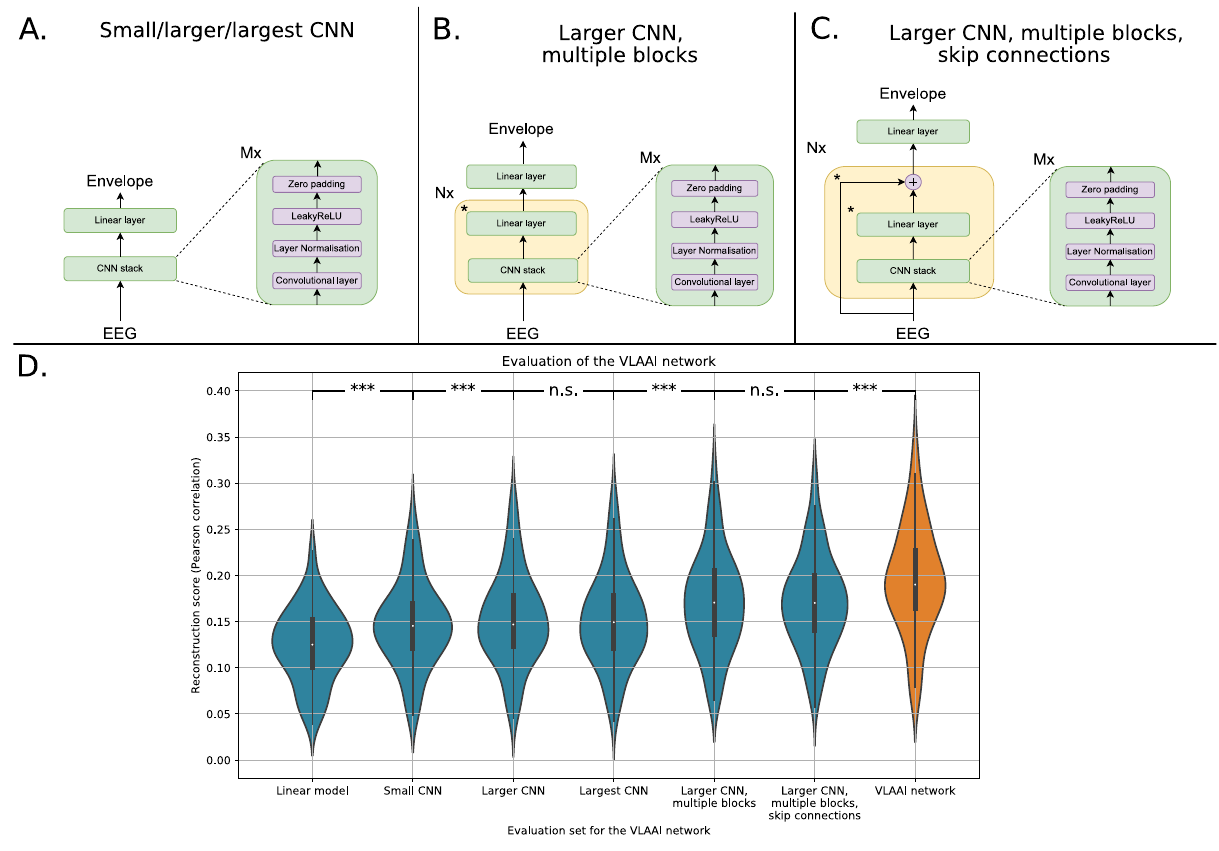
Figure 3. ( A ) The small/larger/largest CNN model. For the small CNN ( M = 2), the convolutional layers have a kernel size of 20 and 256 filters. The large CNN has five convolutional layers ( M = 5) with 256 filters for the first three layers and 128 filters for the last two filters, all with a kernel size of 8. The largest CNN also has five convolutional layers ( M = 5), all with 512 filters and a kernel size of 8. ( B ) The larger CNN, multiple blocks, following the structure of the larger CNN model. The asterisk next to the linear layer highlights that it is not present in the last repetition of that block. For the experiment shown in ( D ), N = 4 and M = 5. ( C ) The larger CNN, multiple blocks, with skip connections (step 5 in ( D )). The asterisk next to the linear layer and skip connection is to highlight that it is not present in the last repetition of that block. For the experiment shown in ( D ), N = 4 and M = 5. (D) Ablation study of the VLAAI network. Each point in the violin plot represents a reconstruction score (Pearson correlation) for a subject, averaged across stimuli. No significant difference was found between the large and largest CNN ( p = 0.68) and between the larger CNN with multiple blocks and the larger CNN with multiple blocks with skip connections ( p = 0.99). The biggest increases in reconstruction score are between the linear model and the small CNN (14% increase in median reconstruction score), the larger CNN with N = 1 and N = 4 (10% increase in median reconstruction score) and when adding the output context layer to the penultimate model to obtain the VLAAI network (10% increase in median reconstruction score). (n.s.: p ≤ 0.05, *: 0.01 ≤ p < 0.05, **: 0.001 ≤ p < 0.01, ***: p <